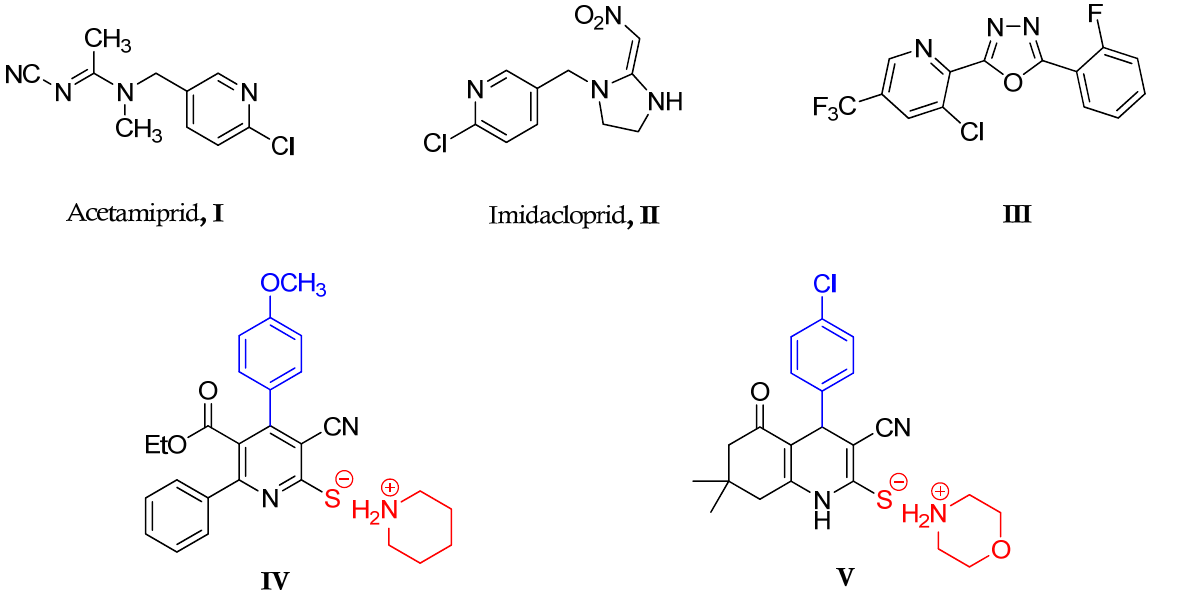
Figure 1. Pyridine I – III and nicotinonitrile IV , V derivatives as molluscicidal agents.